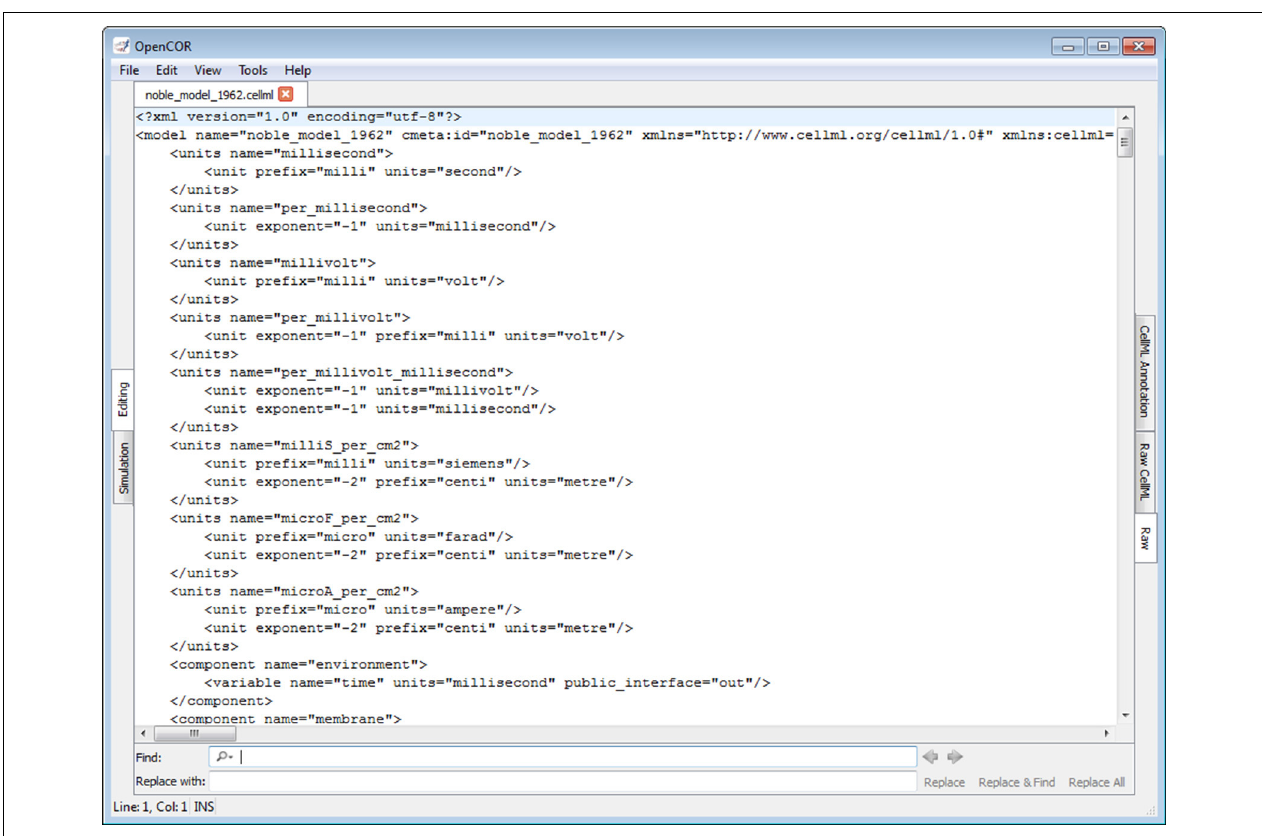
FIGURE 5 | Raw view. The Raw view offers a way to edit files using a text-based